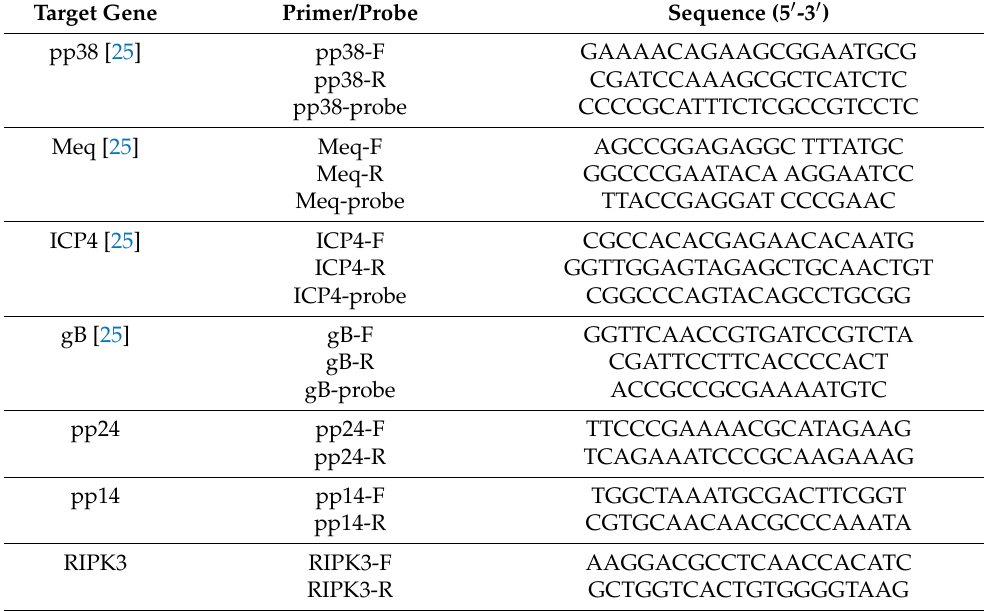
Table 1. Primers and probes used in real-time